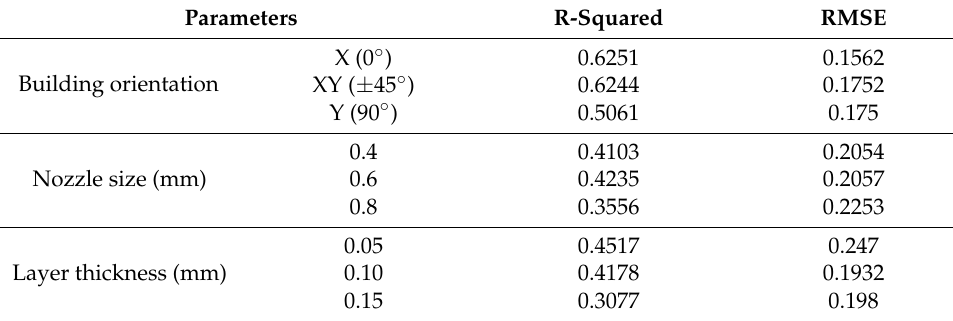
Table 4. R-squared and RMSE for curve fitting of each